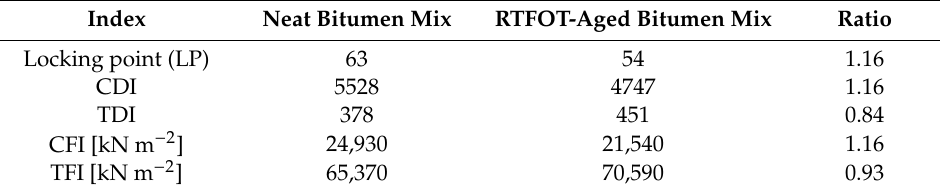
Table 6. Compaction Densification and Compaction Force